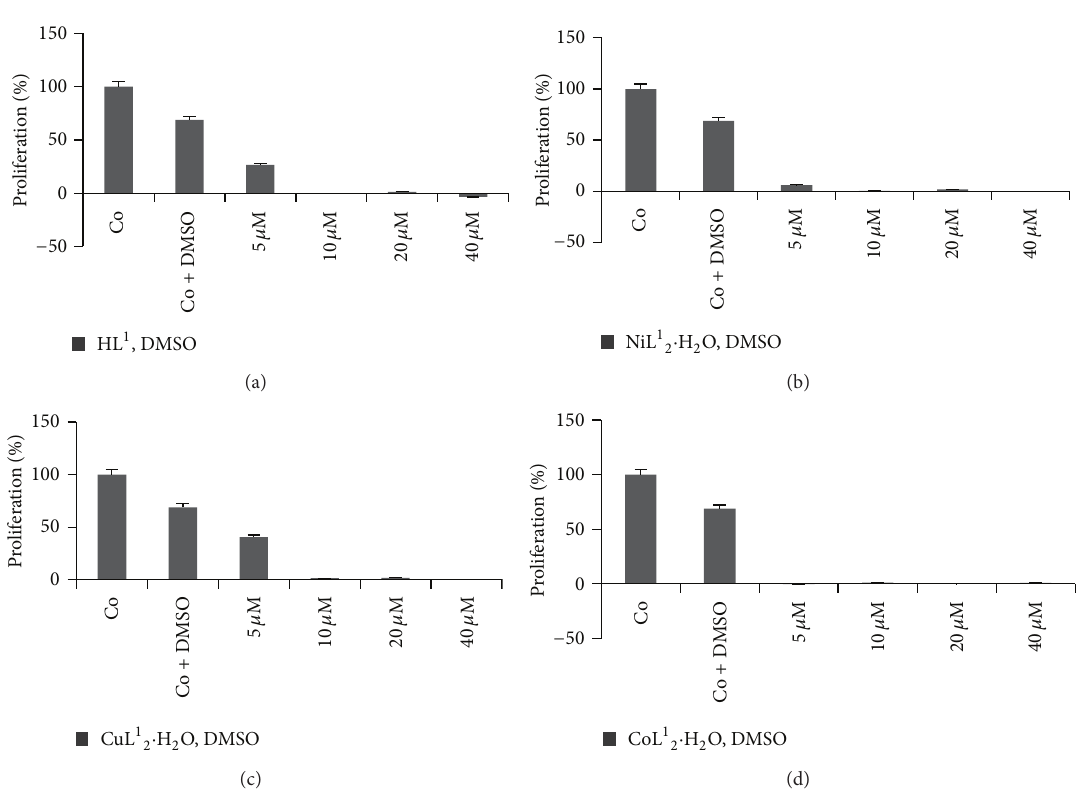
Figure 4: Proposed structures of the metal complexes { M = Co ( II ), Cu ( II ), Ni ( II )} .